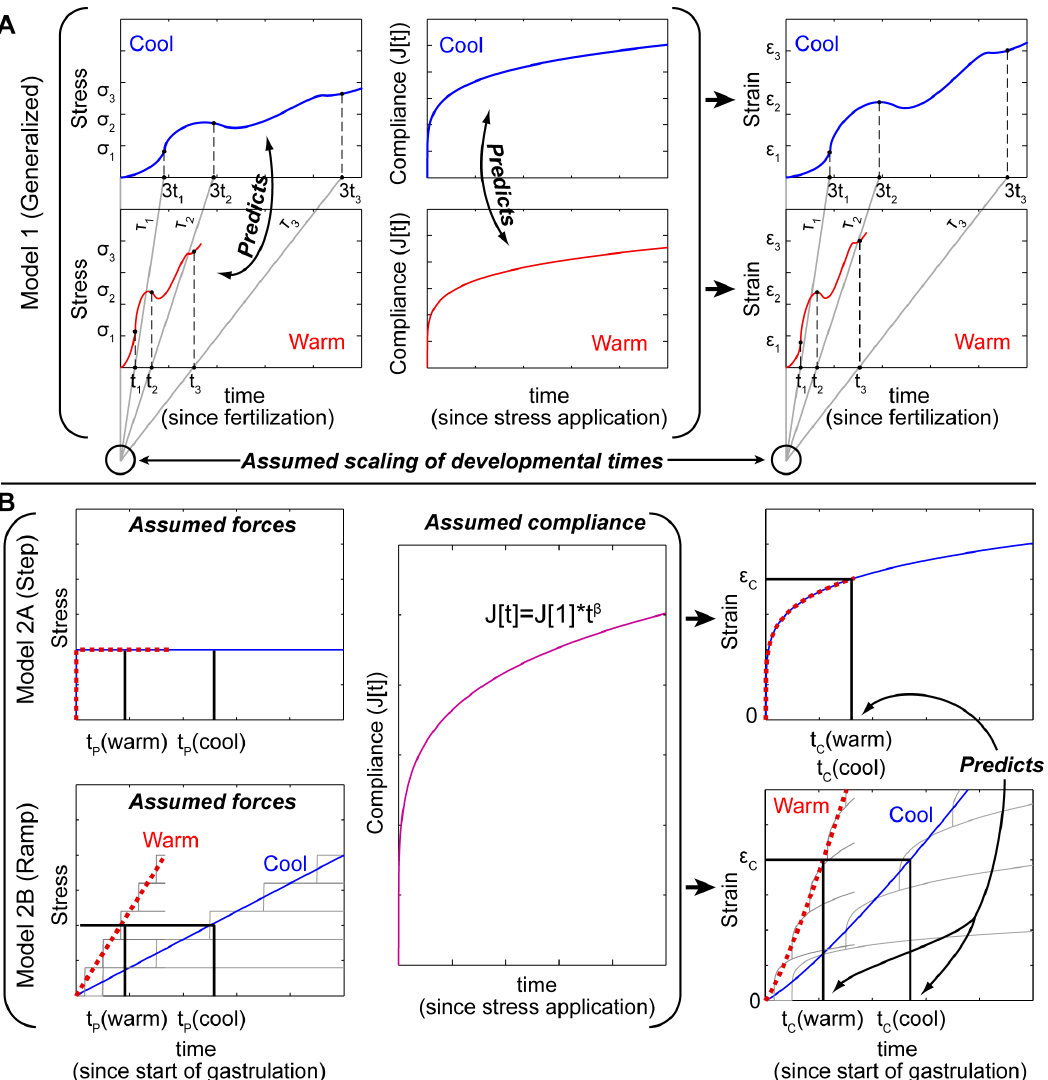
Figure 6. Differences among models. Hypothetical stress (left), creep compliance (middle), and deformation (strain, e ; right) in the tissue. (A) The generalized model (Model 1) assumes the relative timing (oˆ) and the strains, of all events (1, 2, 3,…) are independent of temperature (cool (blue) vs warm (red)), as in a movie played faster. The generalized model does not specify the developmental course of strain or stress, only that timing scales with temperature. The generalized model predicts how stress and compliance vary together as temperature changes (Model 1, eqn.16). (B) Step and ramp models (Models 2A & 2B). The step and ramp models assume morphogenetic stresses are stepped (top) or ramped (bottom) with time. For a step stress (upper), the change in t P with temperature does not affect the time t C to reach strain e C (when the blastopore closes) because peak stress and compliance are unchanged (Model 2A, eqns. 21–22). A ramp is the sum of stress increments (gray lines; bottom left). Stress timing (hence the slope of the ramp) scales with t P , and therefore with temperature (red, warm; blue, cool). The time t C varies with t P (and therefore temperature) for the ramp model (upper; Model 2B, eqns. 25–26), because strain increments follow the change in timing of stress increments (gray lines).